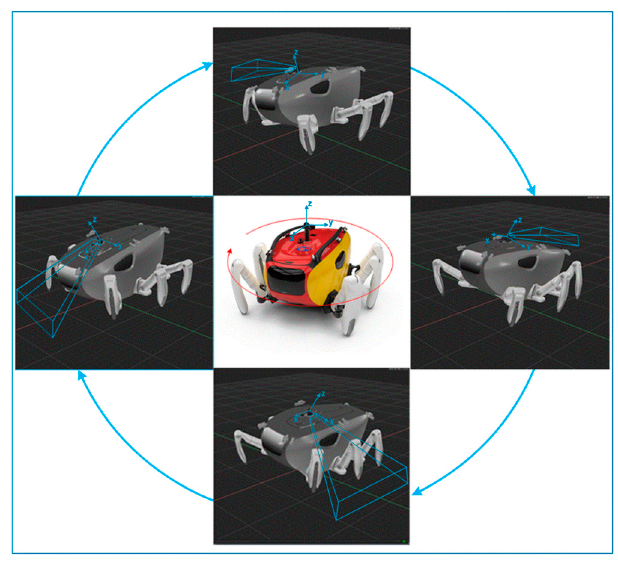
Figure 13. Simulation results of the downward HHM [32].